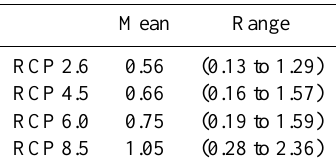
Table 1. Release of carbon from permafrost soils by year 2100 and 2300 for each RCP scenario. Ranges are 5th to 95th percentiles. All values are inPgC.